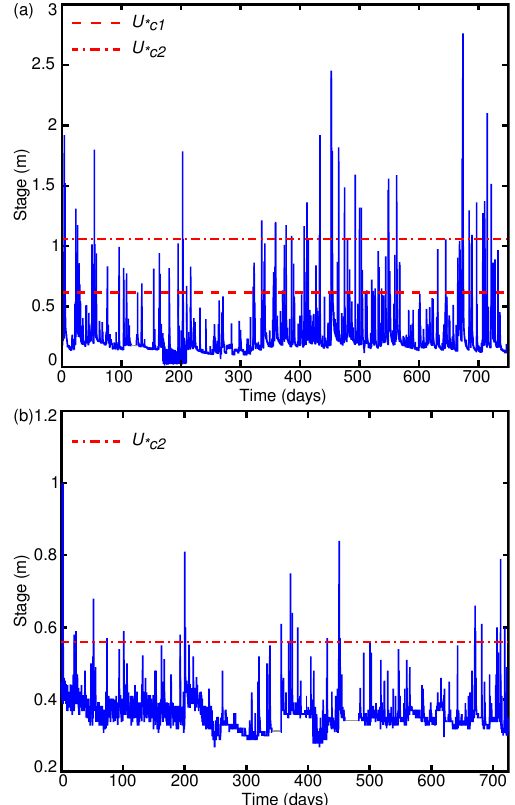
Figure 2. (a) Hydrograph for the duration of the study in depth (m) for the main channel of the Mameyes River. The dashed red lines represent two determinations of the critical shear velocity (ms − 1 ). (b) Hydrograph for the duration of the study in depth (m) for the headwaters field site for the duration of the study. The dashed red line represents the critical shear velocity (ms − 1 ). Gray lines repre- sent missing data.